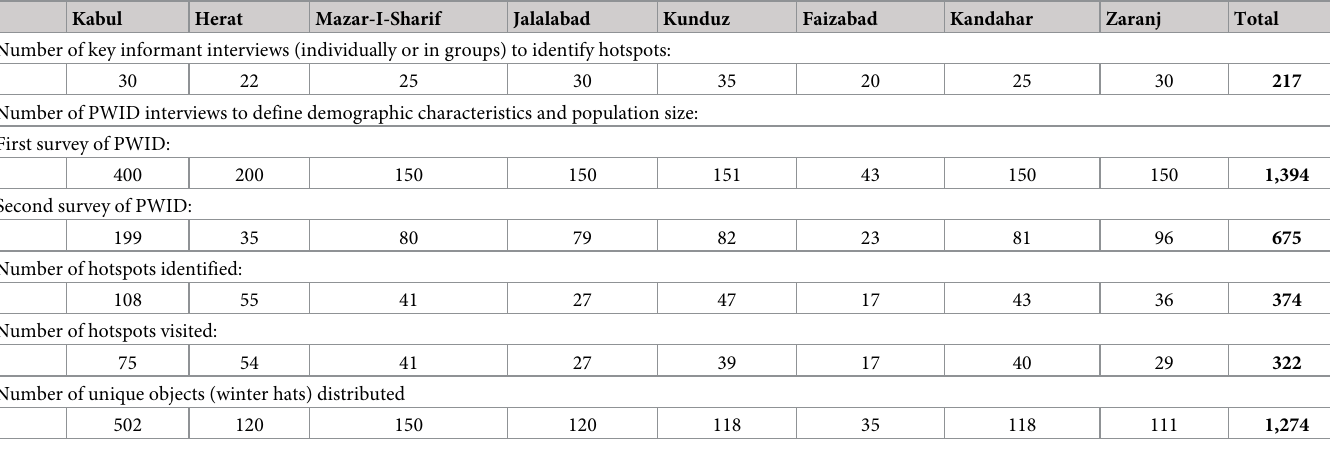
Table 1. Number of interviews, hotspots visited, and unique objects distributed to estimate the number of people who inject drugs (PWID) in different cities in Afghanistan,